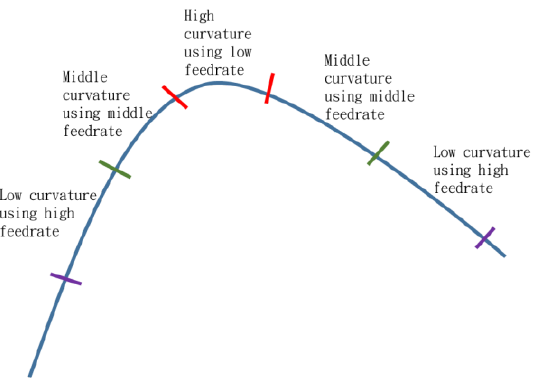
Figure 6. Schematic diagram of machining feed rates. Table 6. Fuzzy control.